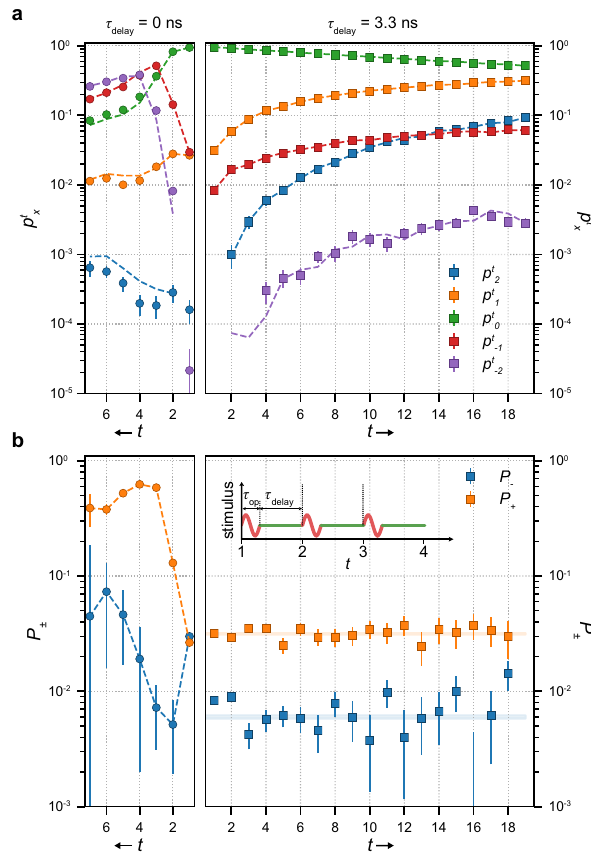
Fig. 3 Memory effect probed at the increased clock frequency. a Measured p t x for device B at a clock frequency of 300 MHz and τ Delay = 0 s (left, t -axis inverted) and τ Delay ¼ 3 : 3 ns (right). Dashed lines represent p t x predicted by deconvolved single-step error rates and p t (cid:2) 1 x . b Single-step t for τ = 0 s (left, t -axis inverted, dashed lines show guide error rates P Delay ± to the eye) and τ Delay ¼ 3 : 3 ns (right, translucent area corresponds to the 1 σ uncertainty estimates). Inset depicts the timing diagram of the sequence — a stimulus of duration τ op drives the transfer operation followed by delay time τ Delay before the next